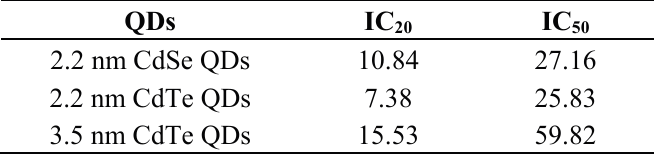
Figure 3. The viability of L929 mouse fibroblasts after a 24 h exposure to three types of QDs (5.85–150 μ g/mL) was assessed using MTT assay. The results are expressed as % mitochondrial activity. Table 1. The calculated IC 20 and IC 50 value of three types of QDs ( μ